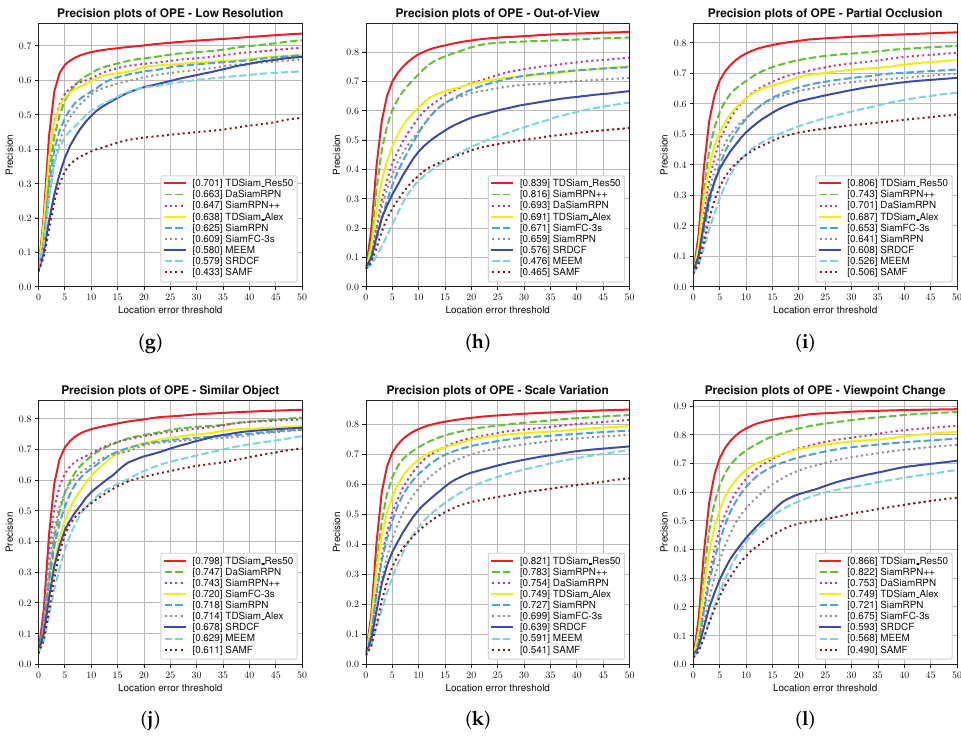
Figure 7. Precision plots corresponding to some typical scenarios. The UAV123 dataset was used for the evaluation. ( a ) Aspect Ratio Change; ( b ) Background Clutter; ( c ) Camera Motion; ( d ) Fast Motion; ( e ) Full Occlusion; ( f ) Illumination Variation; ( g ) Low Resolution; ( h ) Out of View; ( i ) Partial Occlusion; ( j ) Similar Object; ( k ) Scale Variation; ( l ) Viewpoint Change.